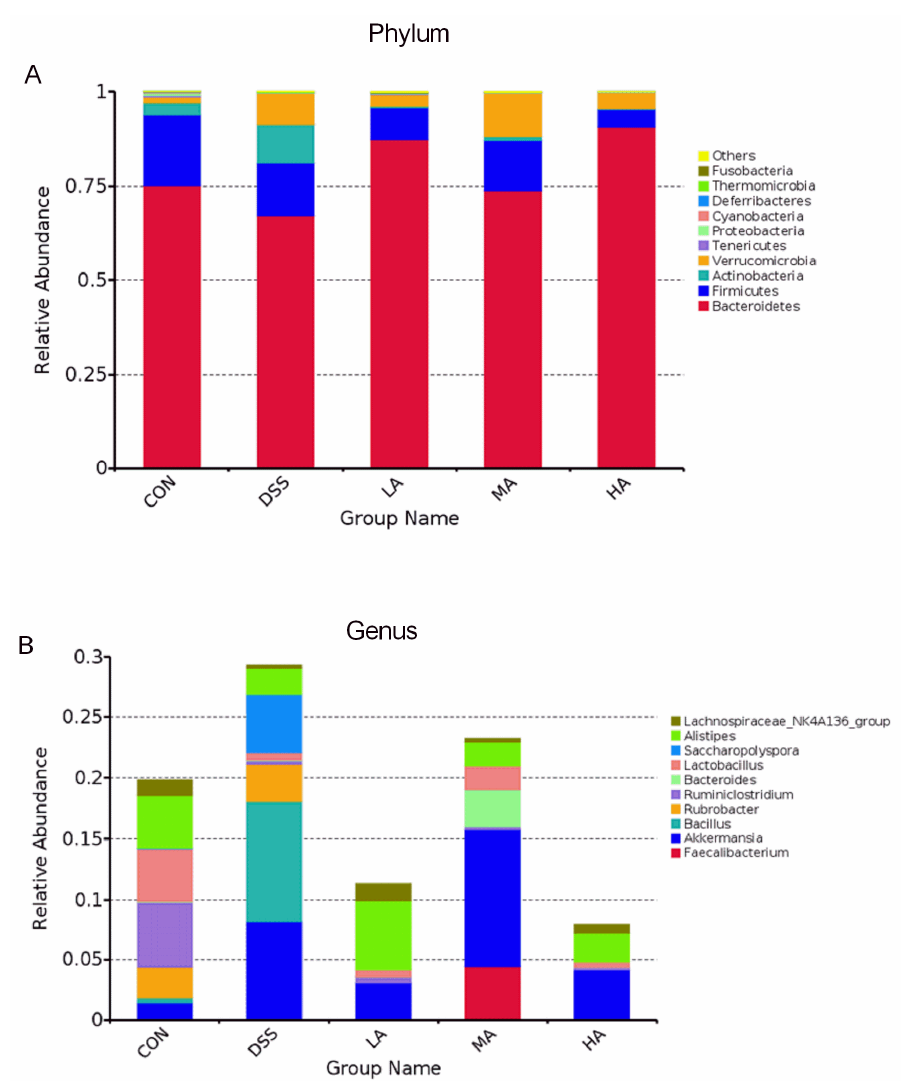
Figure 6. The OTU cluster histogram of the top 10 species with the greatest abundance. ( A ) The top 10 species with the greatest abundance of taxa at the phylum level. ( B ) The top 10 species with the greatest abundance of taxa at the genus